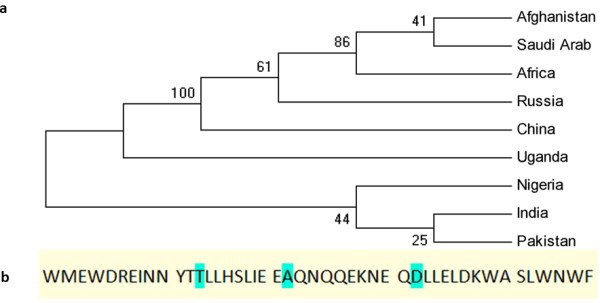
HIV gp41 amino acid sequence: a, Phylogenetic Analysis of HIV gp41 Sequences, b, Position 13, 22 and 32 shown in Blue are most frequently mutated gp41amino acids.